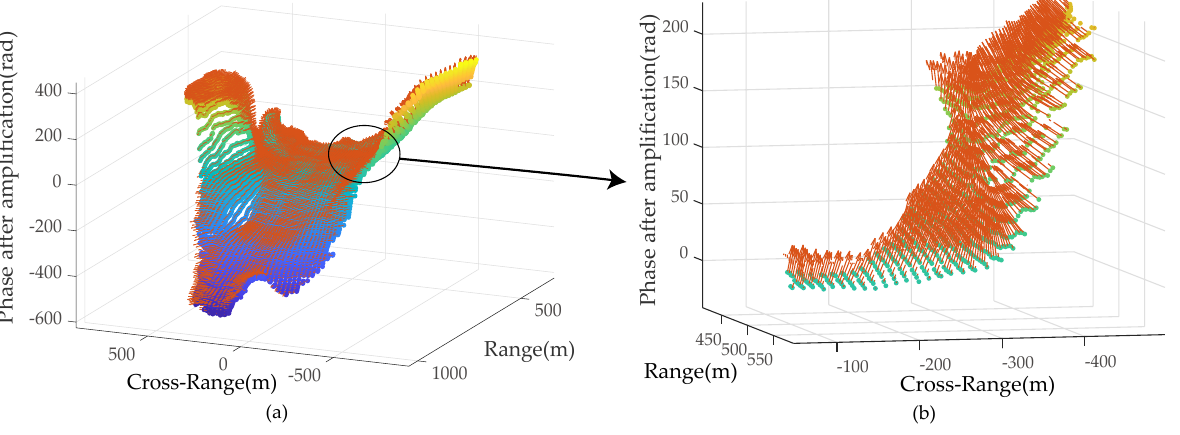
Figure 8. Schematic diagram of normal vector estimation: ( a ) normal vector estimation results of an amplified phase map and ( b ) local details. The orange arrows represent normal